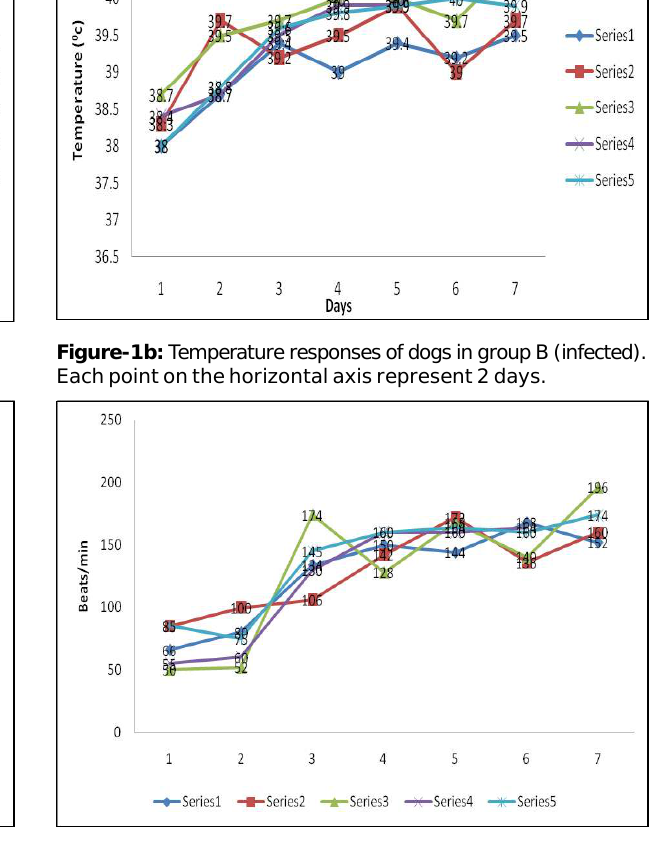
Figure-2a. Pulse rates of dogs in Group A (Control) Figure-2b: Pulse rates of dogs in Group B (infected). point on the horizontal axis represent 2 days.